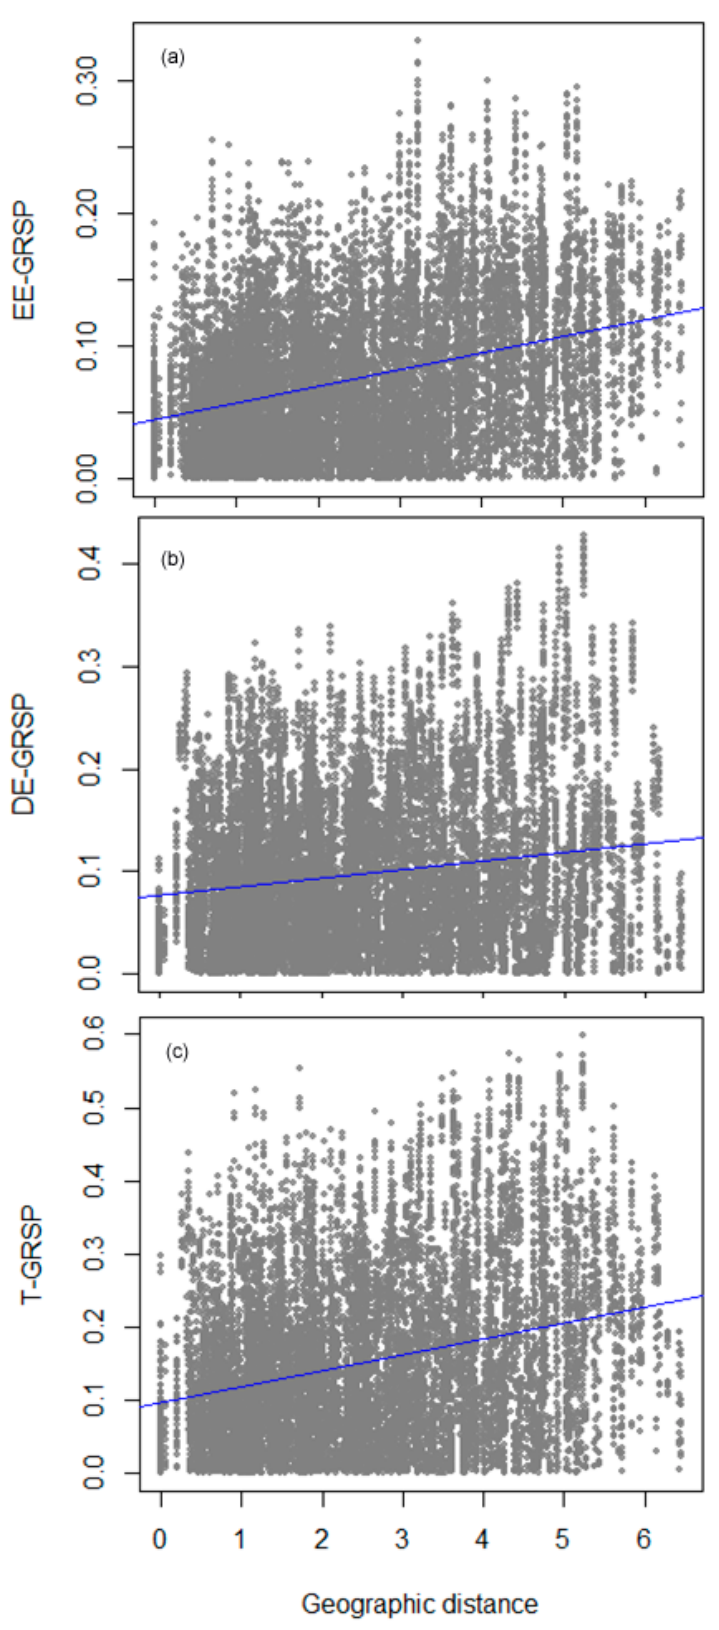
Figure 7. Relationship between EE-GRSP (easily extractable glomalin-related soil protein, a ), DE- GRSP (difficult-to-extract GRSP, b ), and T-GRSP (total GRSP, c ) and geographic distances among sites. 4. Discussion GRSP, a protein produced by AMF hyphae, is related to soil fertility and plays a role in regulating soil quality [7,8]. The content and spatial variation in GRSP, soil chemical properties, and soil enzyme activities in surface soil in the black soil region of northeast China were evaluated in this study. Within the range of the sample sites (across hundreds of kilometers), longitude varied by approximately three degrees, latitude varied by ap- proximately seven degrees, and altitude varied by 185 m. GRSP has been found in the agricultural, forest, grassland, and desert ecosystems. In the present study, the average contents of EE-GRSP and T-GRSP were 0.40 and 0.84 g kg − 1 , respectively, in the black soil region of northeast China, which indicates that the produc- tion of GRSP was low in this area. Singh et al. [32] summarized the contents of GRSP in